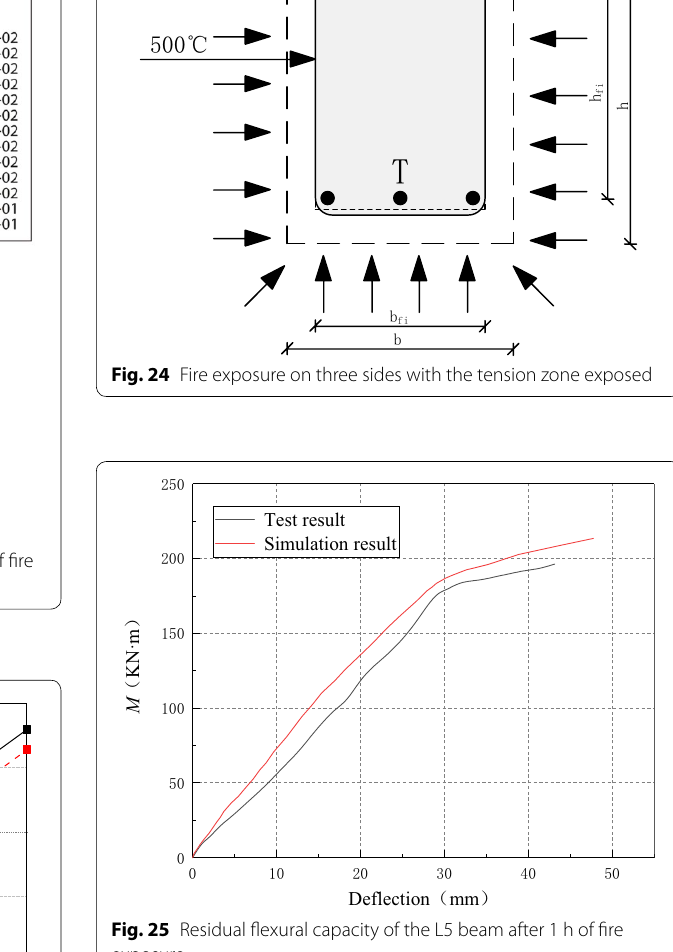
Table 4 Results of the residual flexural capacity of the